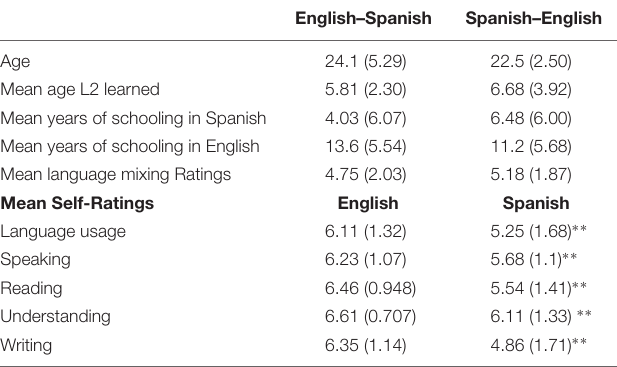
TABLE 1 | Language background information for the bilingual sample.